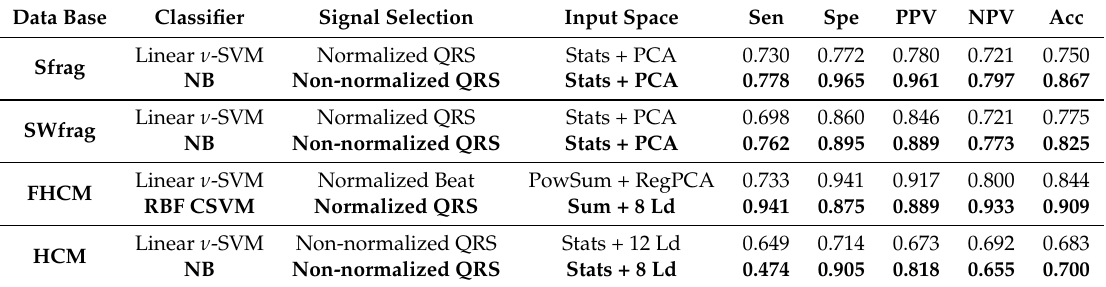
Table 5. Summarized results for the best linear and no linear classifier for each